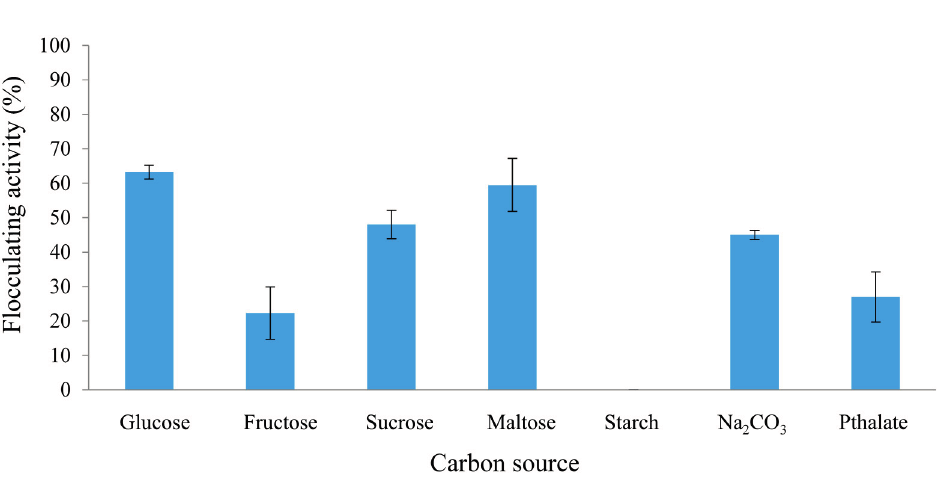
Figure 1. Effect of carbon source on REG-6 production by Bacillus toyonensis strain